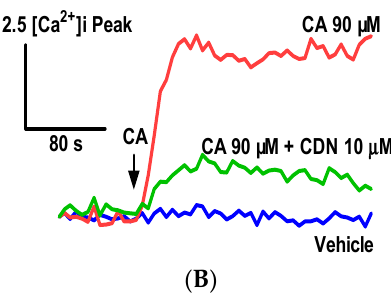
Figure 1. Identification of cardamonin (CDN) as a TRPA1 antagonist. ( A ) Scatterplot of inhibitory rates of 156 herbal derived chemicals on TRPA1 activation. Cinnamaldehyde (CA) was applied as a TRPA1 agonist to stimulate calcium mobilization at 90 μ M. A-967079 (1 μ M) was used as a positive TRPA1 antagonist control. 50% inhibition rate was defined as the cutoff; and ( B ) representative time-course profile of CDN on TRPA1 agonist CA stimulated calcium signal. The arrow indicates the onset of 90 μ M CA.